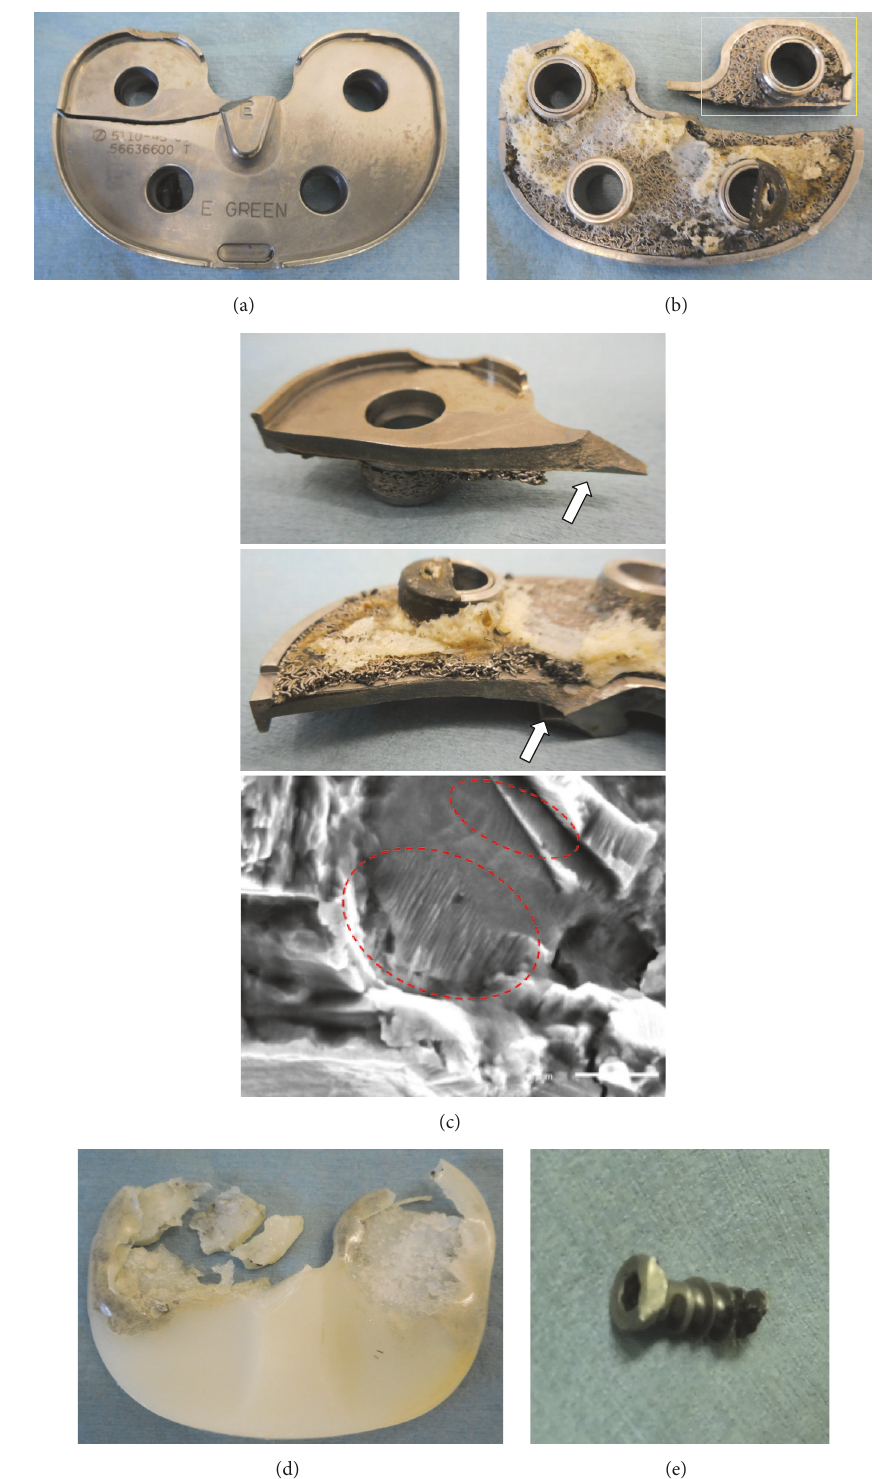
Figure 6: (a) Gross observation of the retrieved broken tibial baseplate reveals that the fracture line extended in a coronal direction from the medial corner to the posterior cruciate ligament (PCL) recess. (b) Gross observation of the undersurface of the tibial baseplate shows uneven bone attachment surrounding the medial fracture line but even bone attachment at the posterolateral portion. (c) Surface of the break is complex rather than with regular fracture waves. A focal stair-step pattern can be observed grossly at the medial corner of the PCL recess (arrow), indicating a fatigue fracture. Scanning electron micrography shows fatigue striations (circle). (d) Retrieved polyethylene insert has severely worn medial sites that correspond to the posteromedial breakage area of the tibial baseplate. Polyethylene insert is also severely worn at the posterolateral area. (e) Retrieved portion of the fractured